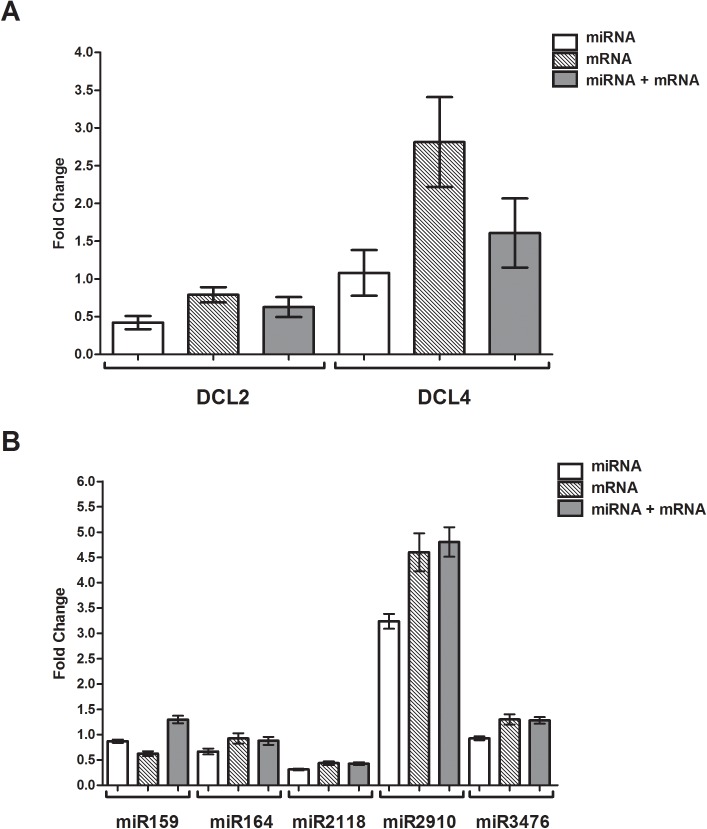
Validation of the RGs by the relative expression of miRNAs and mRNA targets in virally infected (CLRDV) cotton.The relative quantitative values of A—cotton Dicer-like (DCL2 and DCL4) and B—miR159, miR164, miR2118, miR2910, miR3476 cotton miRNA transcripts were obtained by scaling to uninfected leaves samples and the normalizations were done using reference genes sets of miRNAs: miR172, miR168, and miR390; mRNAs: GhACT, GhPP2A, and GhEF, and miRNA and mRNA: miR168, miR390, and GhPP2A. The gene expression was analyzed using the 2-ΔΔCt method and statistical tests were calculated using two-way ANOVA. The significance level between the relative expression values of infected and uninfected leaves, determined by the Bonferroni method, ranged between 000.1>p<0.005 in (A) and (B). No statistical support was obtained for miR2118 normalized with mRNA and with miRNAs and mRNAs.